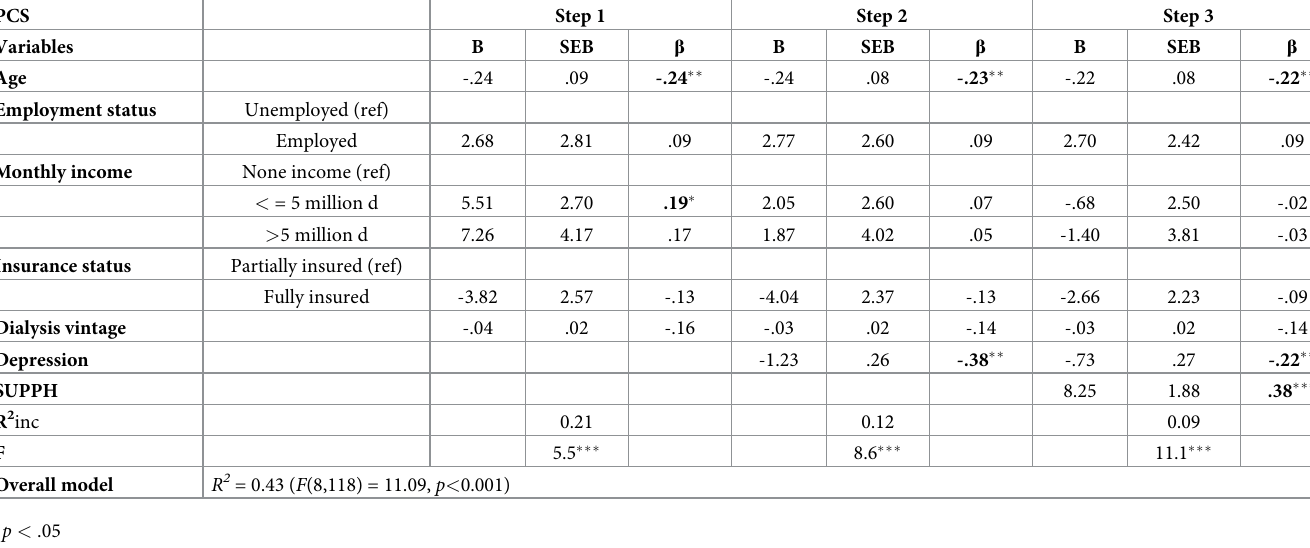
Table 5. Hierarchical multiple regression analysis for demographics, depression, and self-care self-efficacy (SUPPH) predicting PCS ( n = 127). PCS Step 1